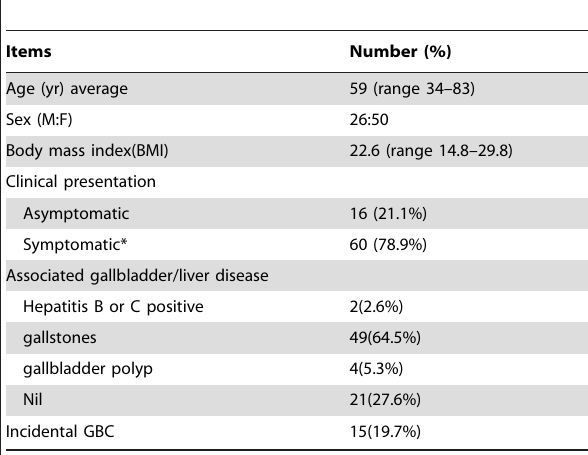
Table 1. Clinical characteristics of the 76